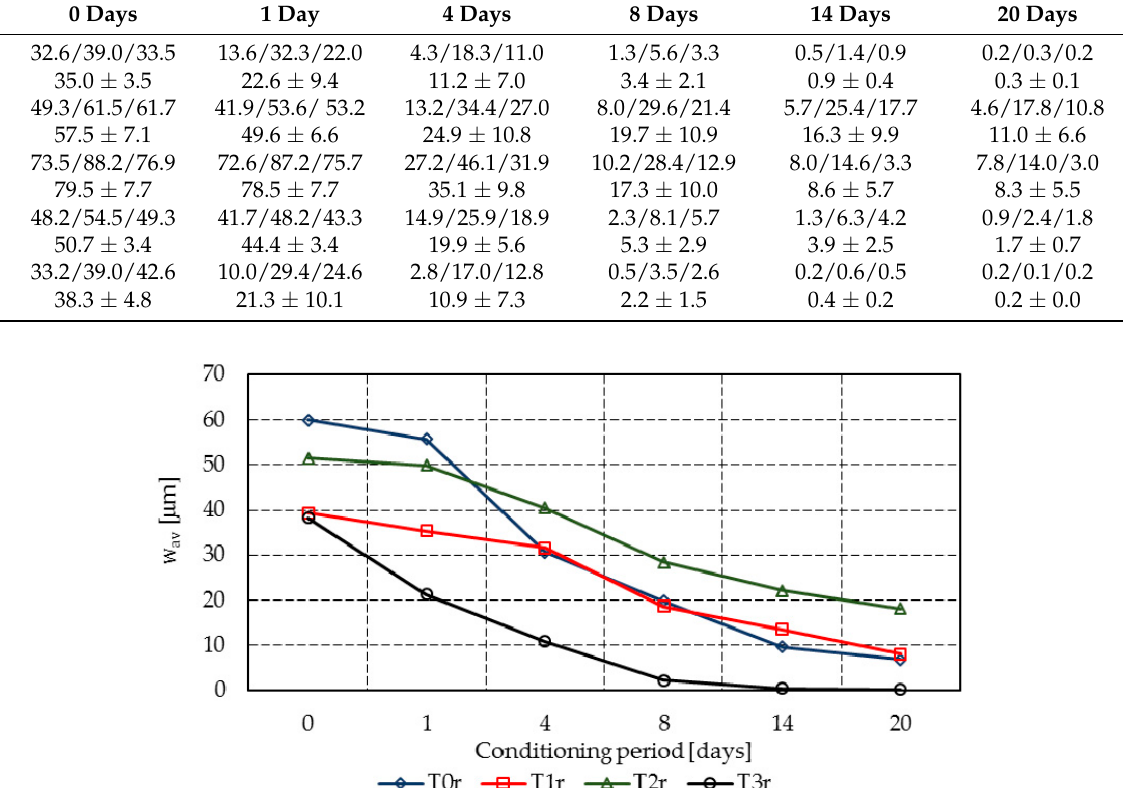
Figure 4. Mean crack progress in mixtures T0r–T3r.